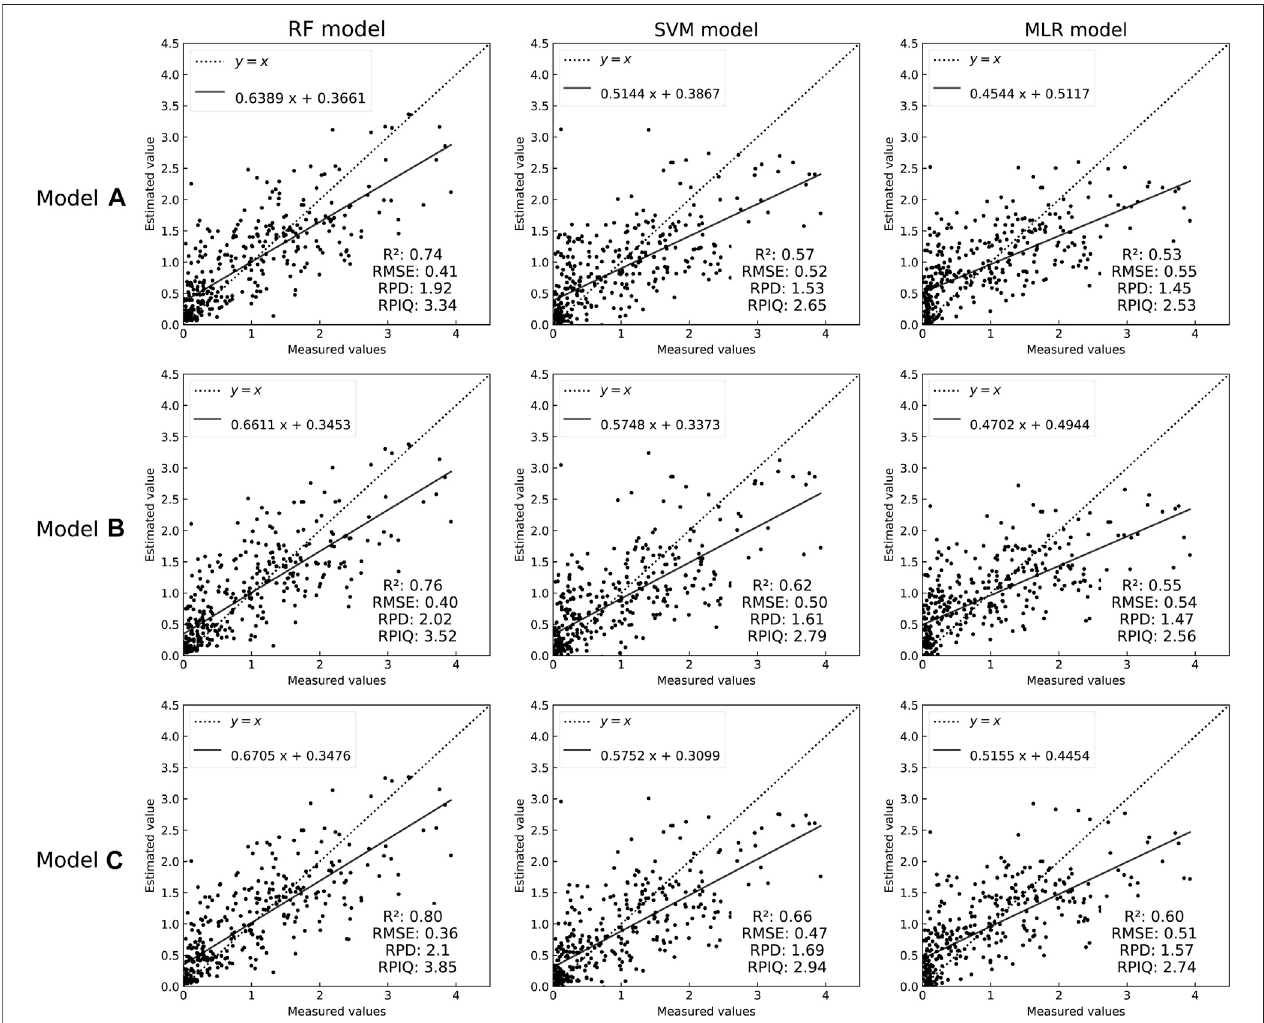
FIGURE 4 | Model accuracy evaluation scatter plot. Models A,B, and C refer to covariate sets A,B, and C, respectively. RMSE – root mean square error, RPD – ratio of prediction deviation, RPIQ - ratio of performance to interquartile distance.